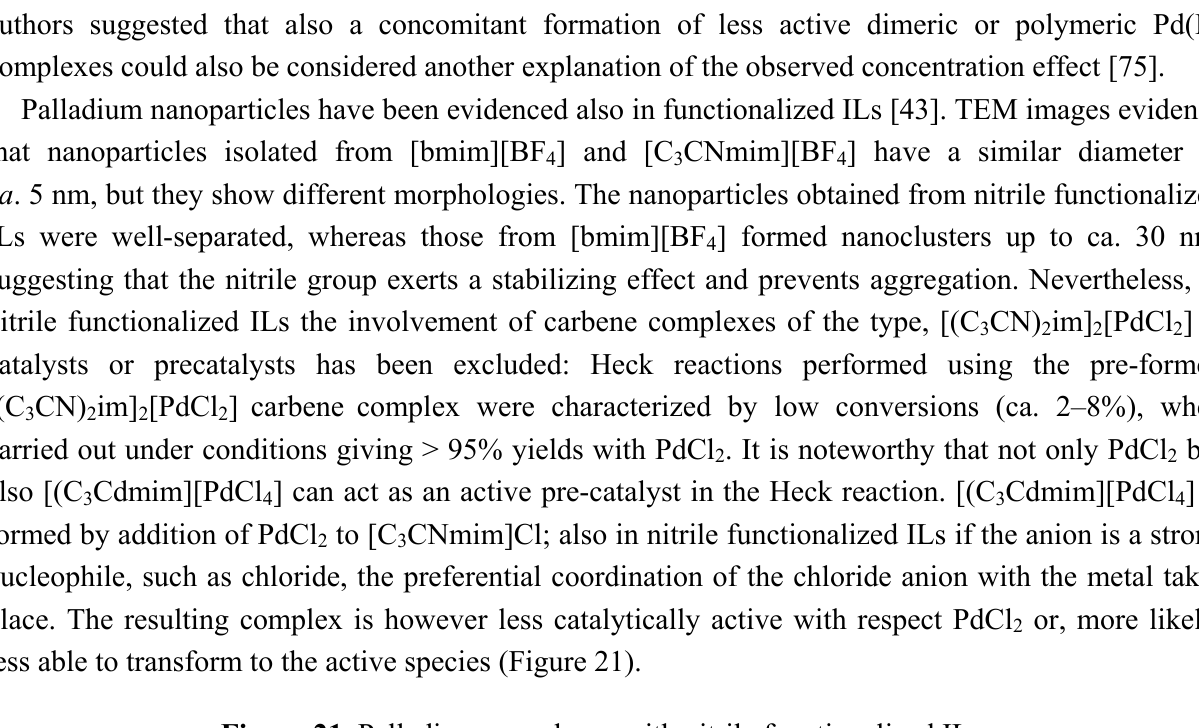
Figure 21. Palladium complexes with nitrile functionalized